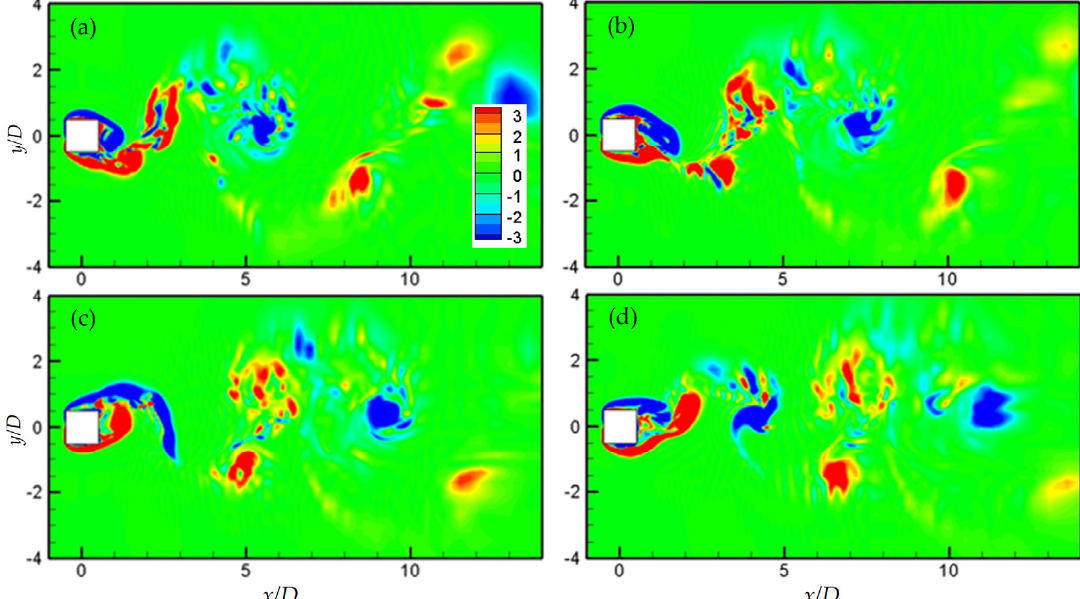
Figure 12. Instantaneous contours of the spanwise vorticity ω z for α = 0 ◦ on the ( x , y ) plane at z = 4 D within one vortex shedding period T. ( a ) t = 0; ( b ) t = T/4; ( c ) t = 2T/4; ( d ) t = 3T/4.